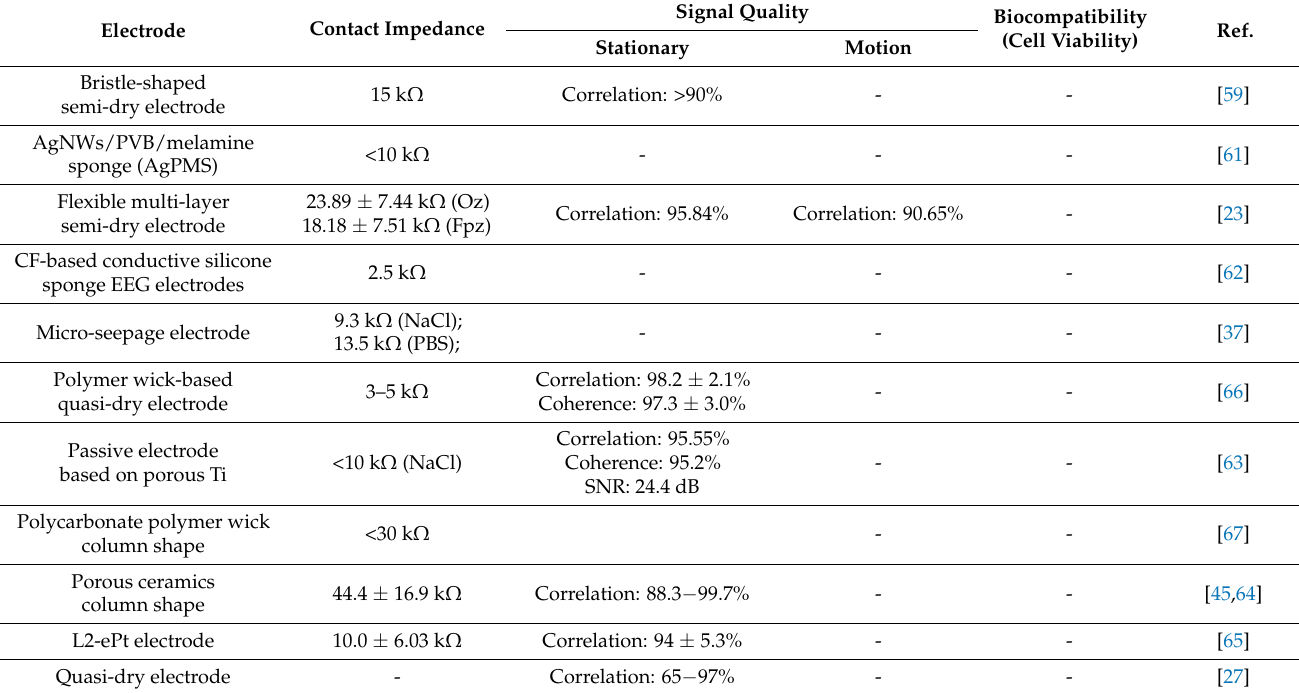
Table A2. Comparison of performance of the selected semi-dry EEG electrode.